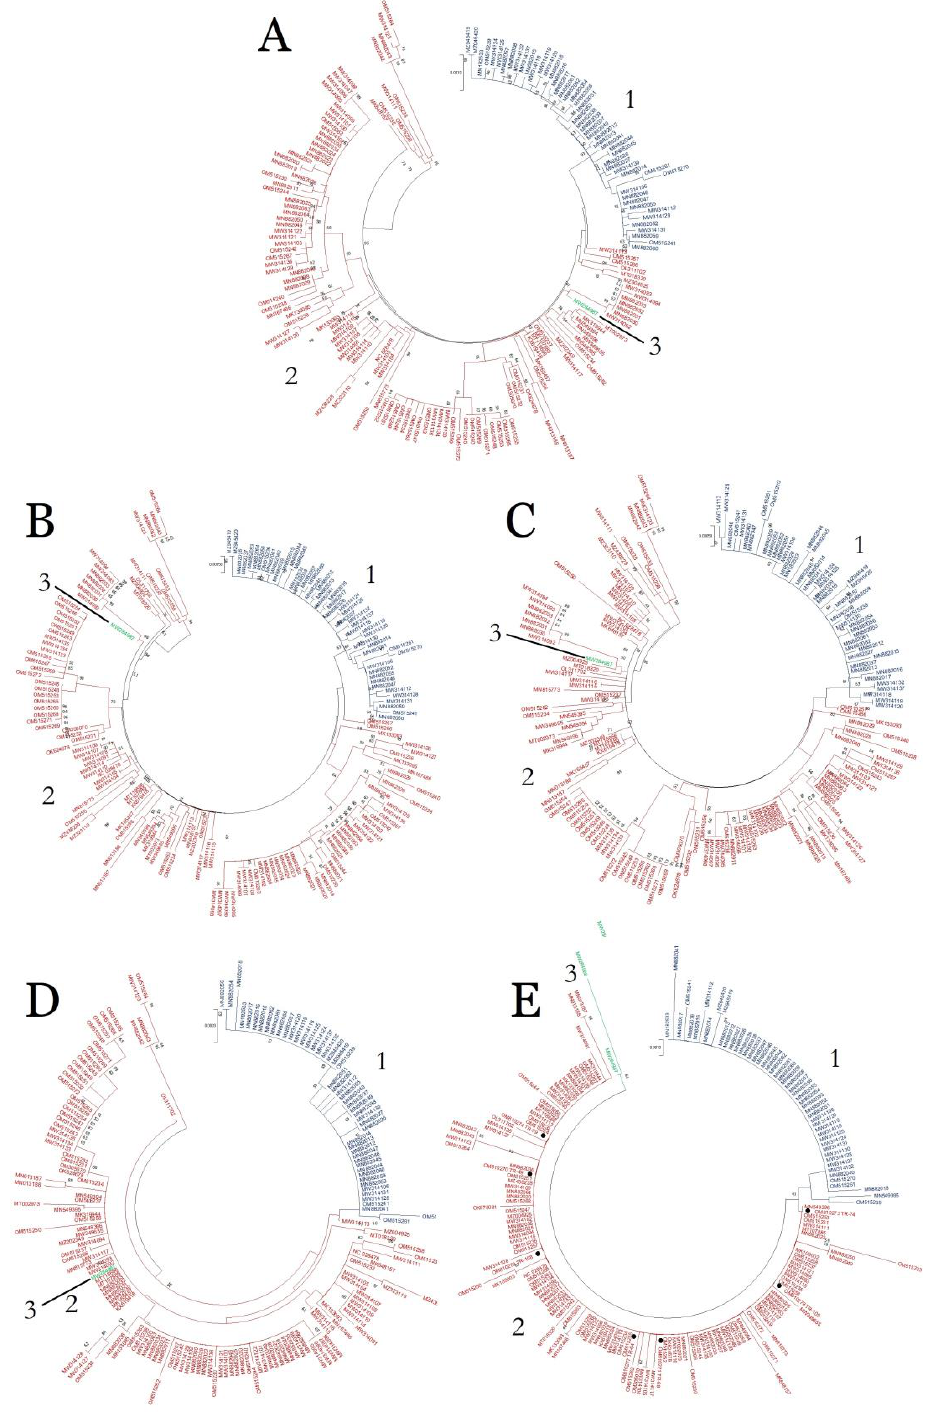
Figure 2. Neighbor-Joining phylogenetic analysis using Tamura 3-parameter model (TN92) with uniform rates among sites (1000 bootstrap replicates, only >50% values were shown) by MEGA X software to show the distribution of 174 isolates in each phylogenetic tree based on ( A ) the complete genome, ( B ) ORF1, ( C ) ORF2, ( D ) ORF3 (MP), and 185 isolates for ( E ) ORF4 (CP). The three phylogrouping systems (1: Blue; 2: Red; and 3: Green) were based on CP tree. Black dots are seven Turkish isolates identified in the present